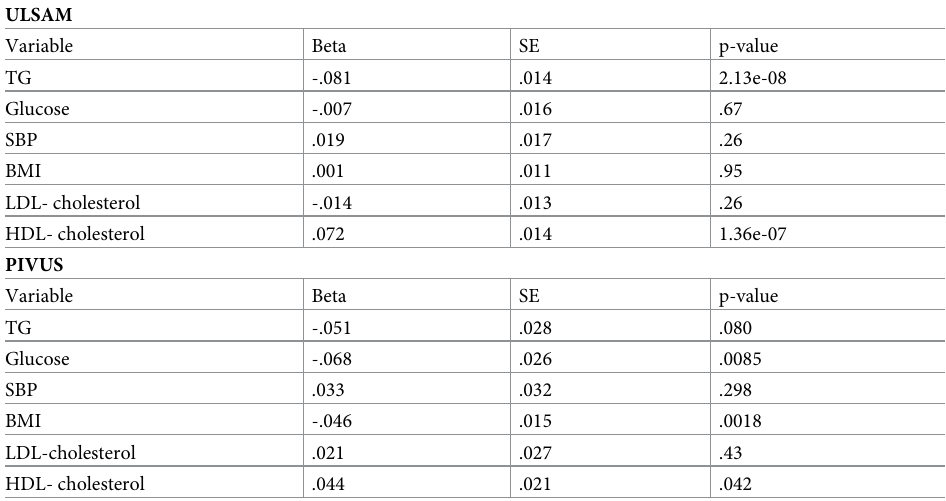
Table 2. Relationships between changes in cardiovascular risk factors and change in physical activity from age 50 to age 82 in ULSAM, and between age 70 and 80 in